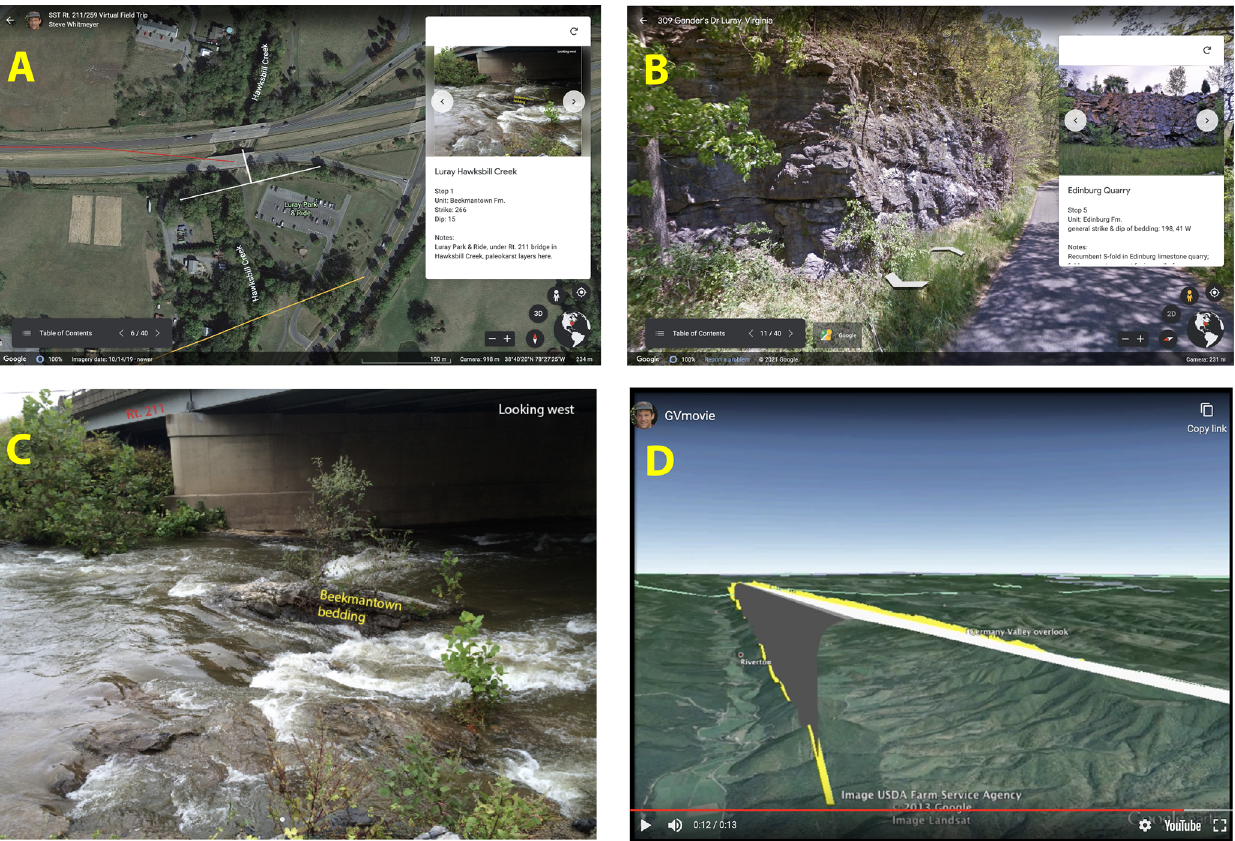
Figure 3. Screen images from web-based © Google Earth virtual field trips from the Mid Atlantic Appalachian Orogen Traverse project; (a) a virtual field trip site that shows a bird’s-eye view of the outcrop location with an oriented strike and dip symbol drawn as a polyline in © Google Earth and a pop-up box with outcrop information and slide carousel; (b) a virtual field trip site that shows a zoomable and rotatable Street View image of the outcrop; (c) an annotated photo of a field site, shown as an enlarged image from the © Google Earth slide carousel from (a) ; (d) a model of a regional anticline displayed as a pop-up YouTube movie from the © Google Earth slide